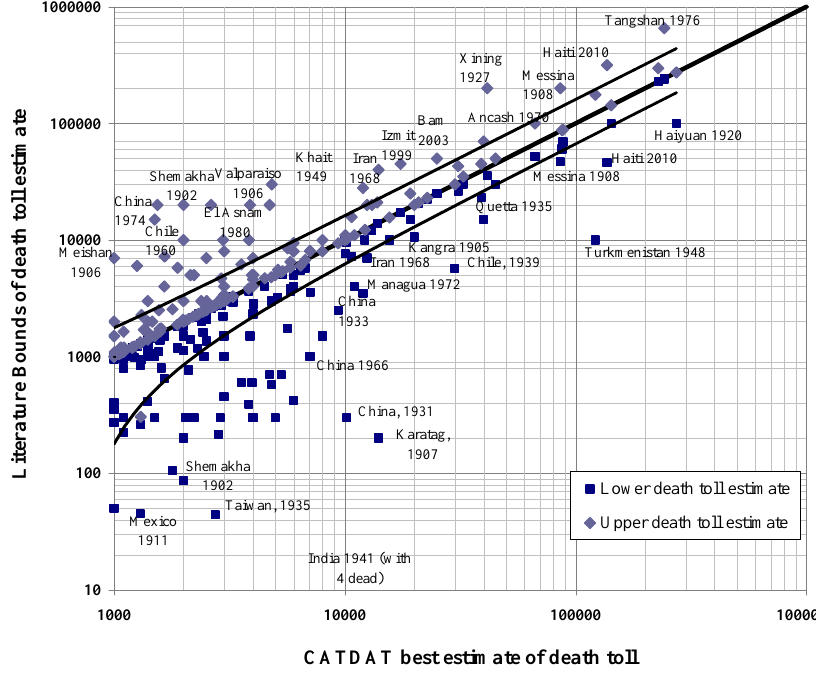
Fig. 8. CATDAT v5.024 Damaging Earthquakes median death toll as compared to the upper and lower death toll estimates in global literature.